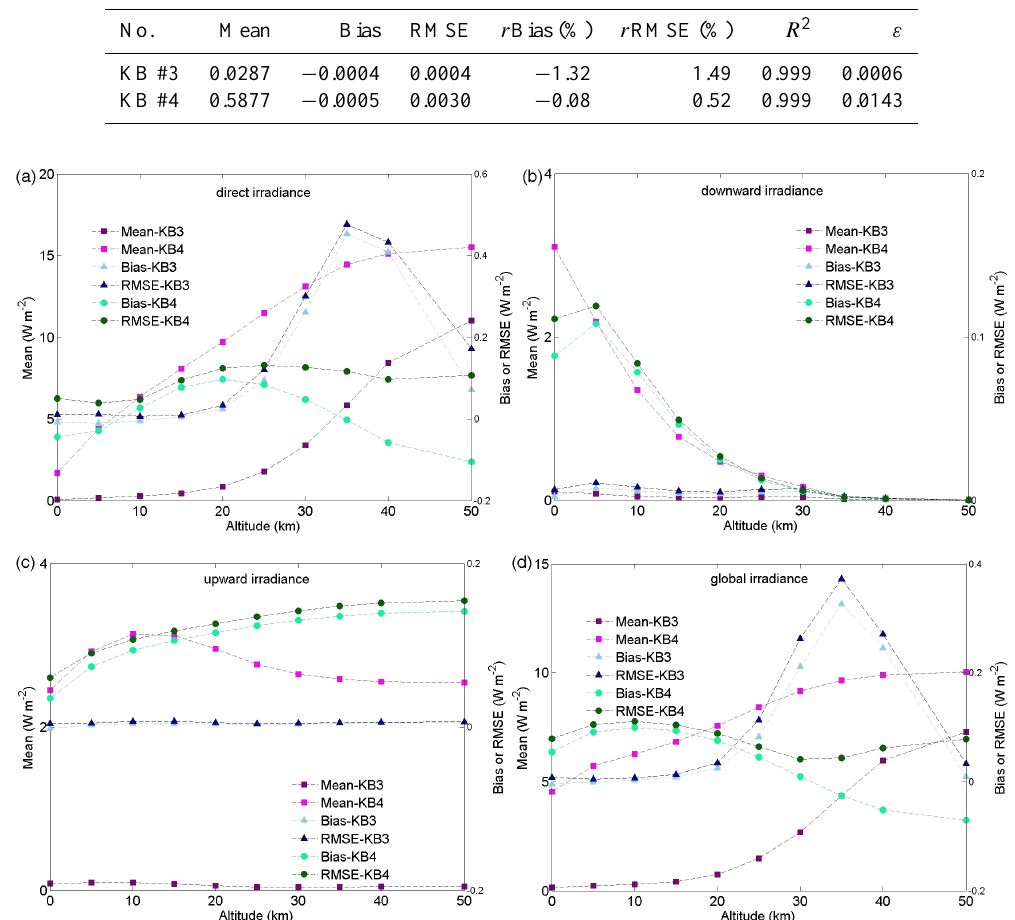
Table 2. Statistical indicators obtained by using the new parameterization for computing the transmissivity due to the sole ozone absorption in each Kato band. No. is the number of KB, R 2 is the squared correlation coefficient, mean is the mean value of the reference average transmissivity, ε is the maximum error.